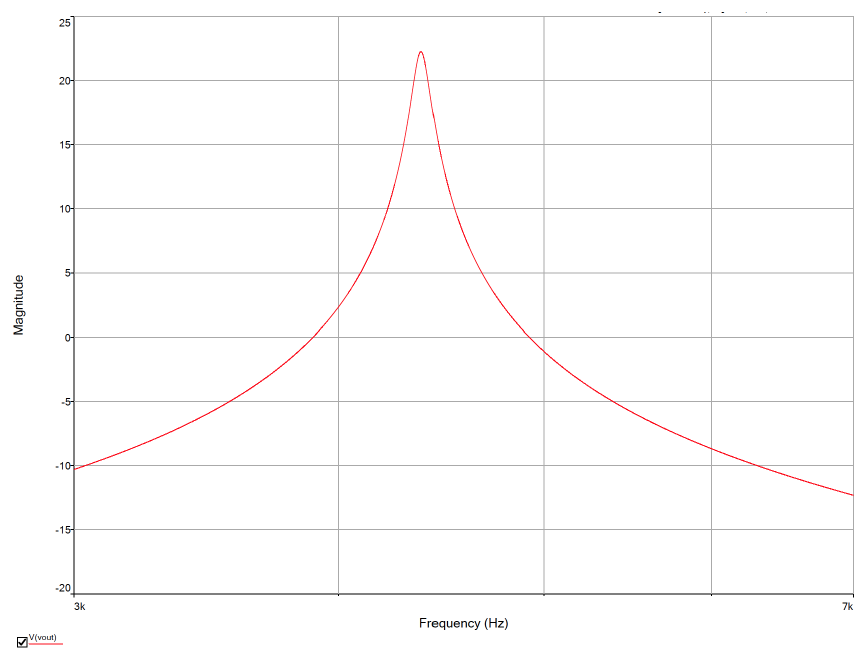
Figure 4. Frequency response of the biquadratic bandpass filter shown in Figure